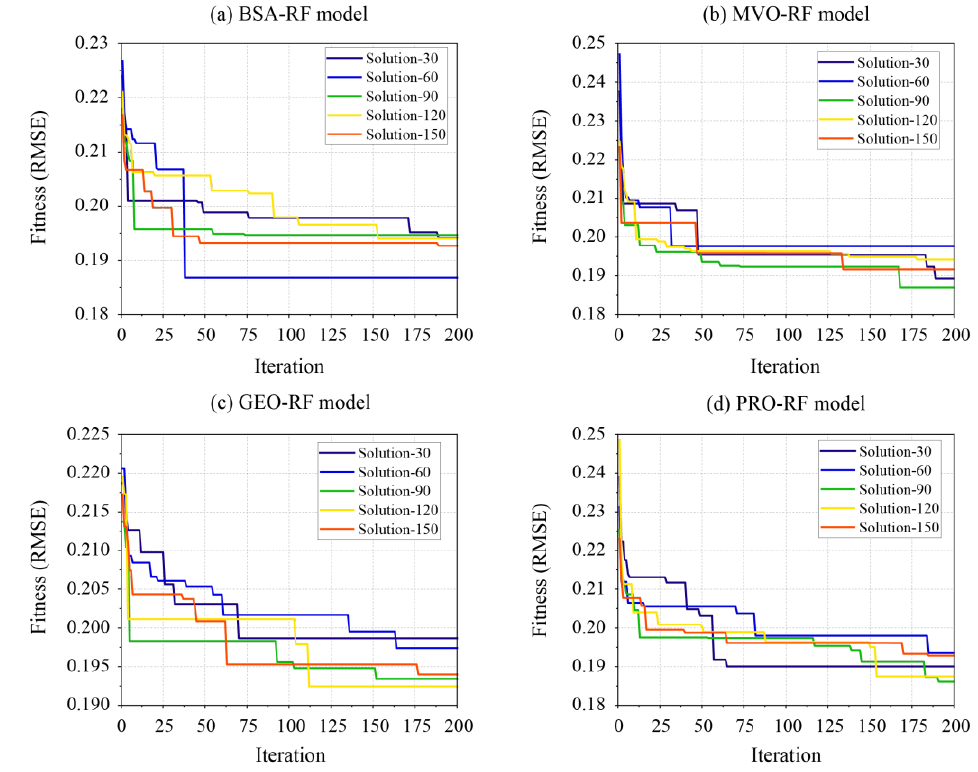
Figure 6. Iteration curves of four hybrid RF models for predicting the rock EM.